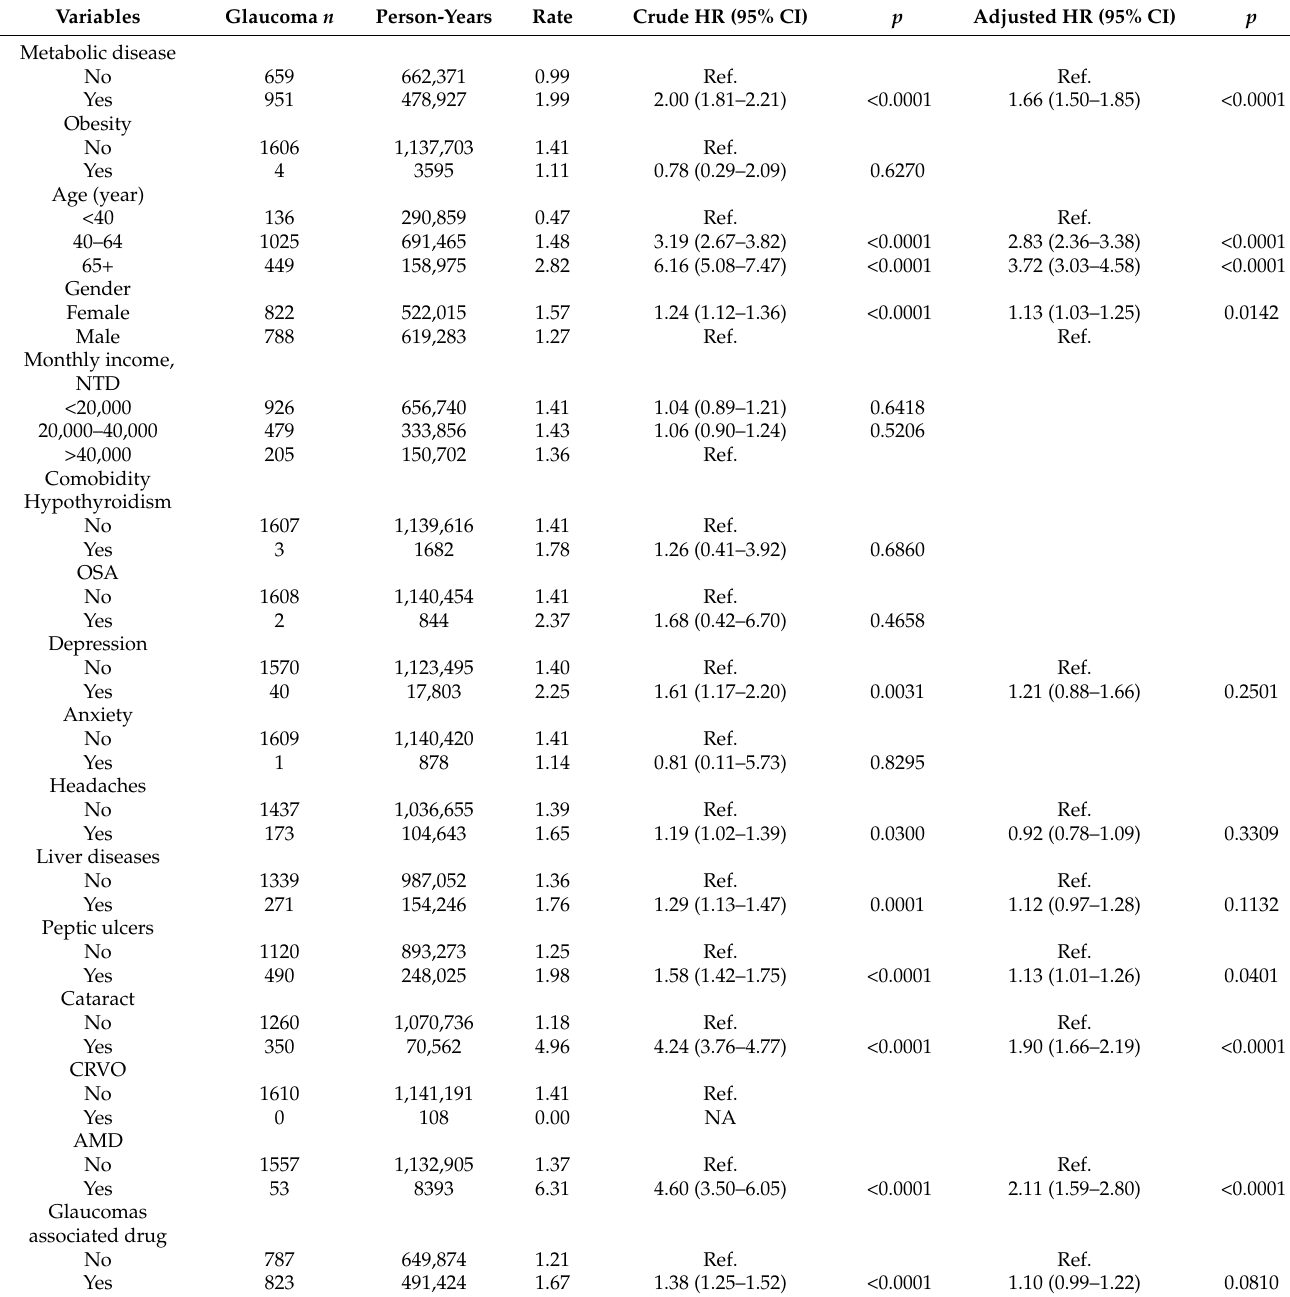
Table 2. Incidence and hazard ratio of glaucoma by metabolic disease, demographic status, comor- bidity and drugs may induce glaucoma in pooled study